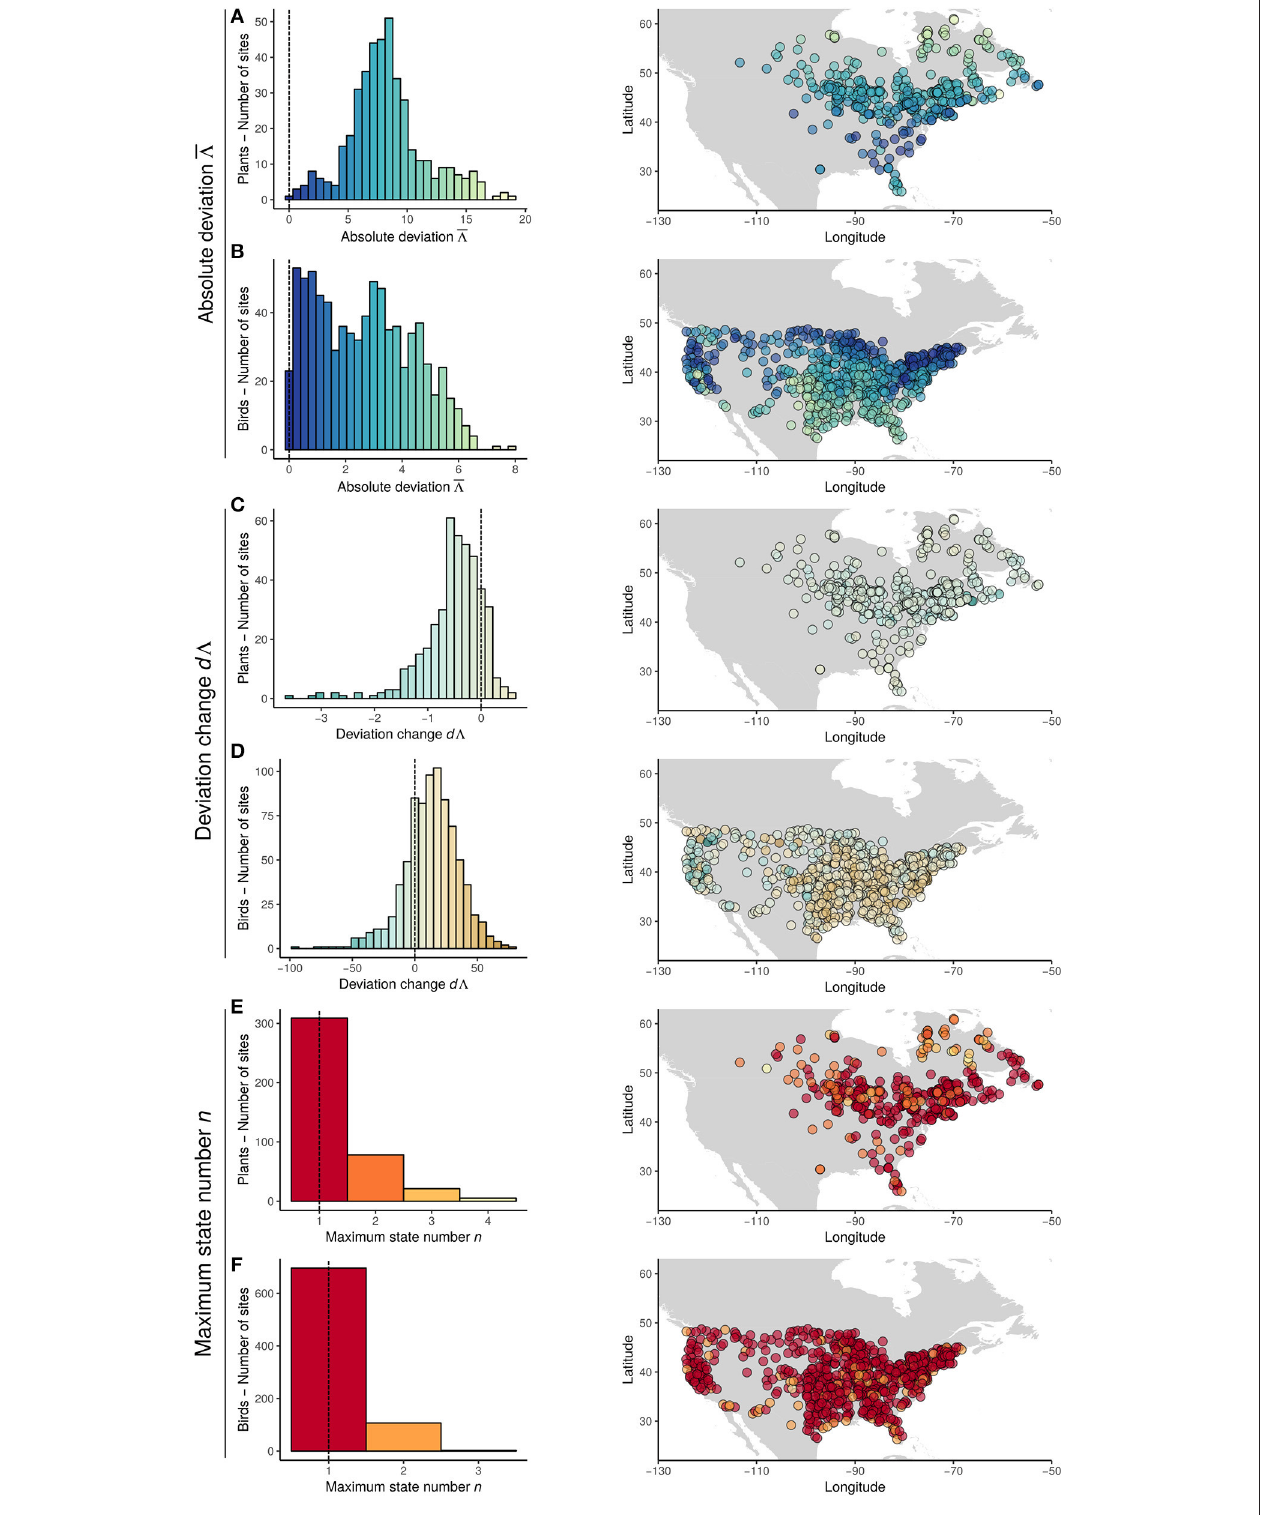
FIGURE 3 | Distributions (left panels) and maps (right panels) of summary statistics ( A,B : absolute deviation ¯ 3 ; C,D : deviation change d 3 ; E,F: maximum state number, n ) estimated from CRD for plants (A,C,E) and birds (B,D,F) . Colors correspond to the statistics value, as shown in distributions. Broken black lines represent expectation from no-lag